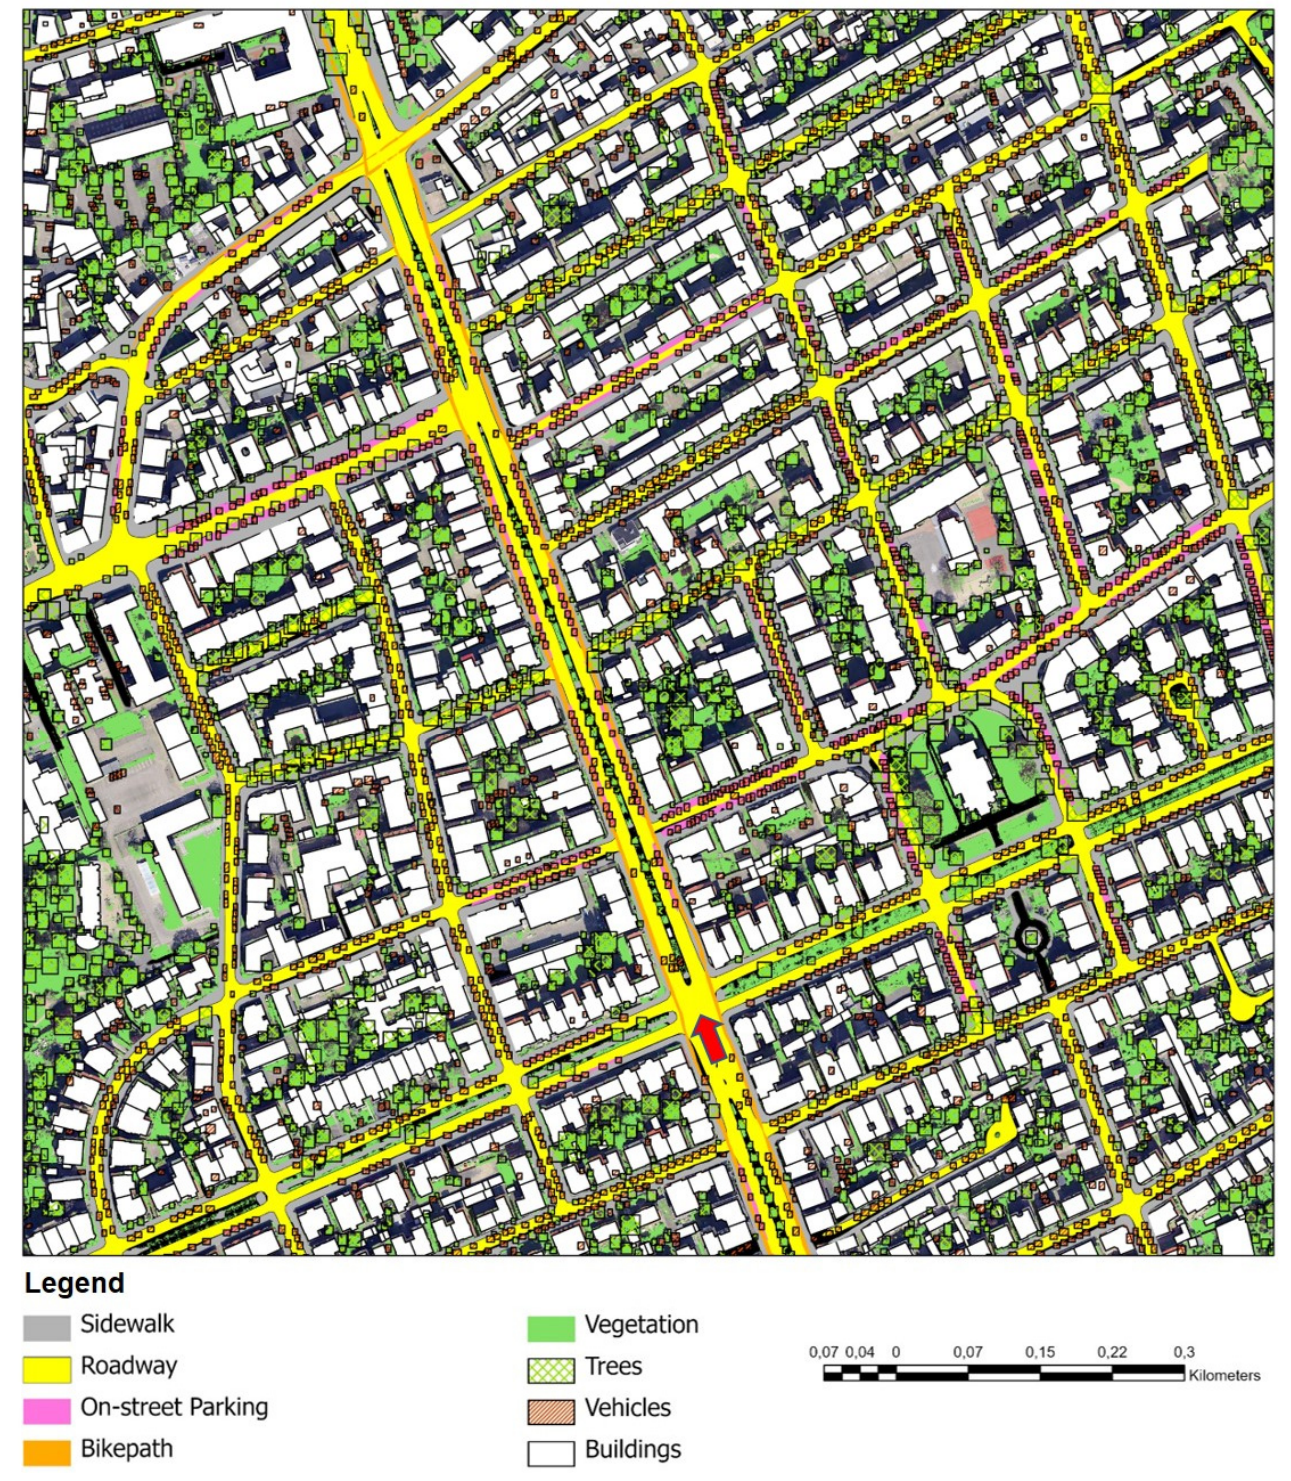
Figure 10. Combined outputs from all the segmentation and detection models. The generated combined geospatial dataset is further utilized to create street-cross sections with the help of Blender software (v 2.93). Blender is one of the industry-leading 3D computer graphics and media creation software and can integrate various workflows with maximum control over the user-defined processes. However, Blender maps its objects in Cartesian coordinates, which has limited applicability to our intent. Therefore,